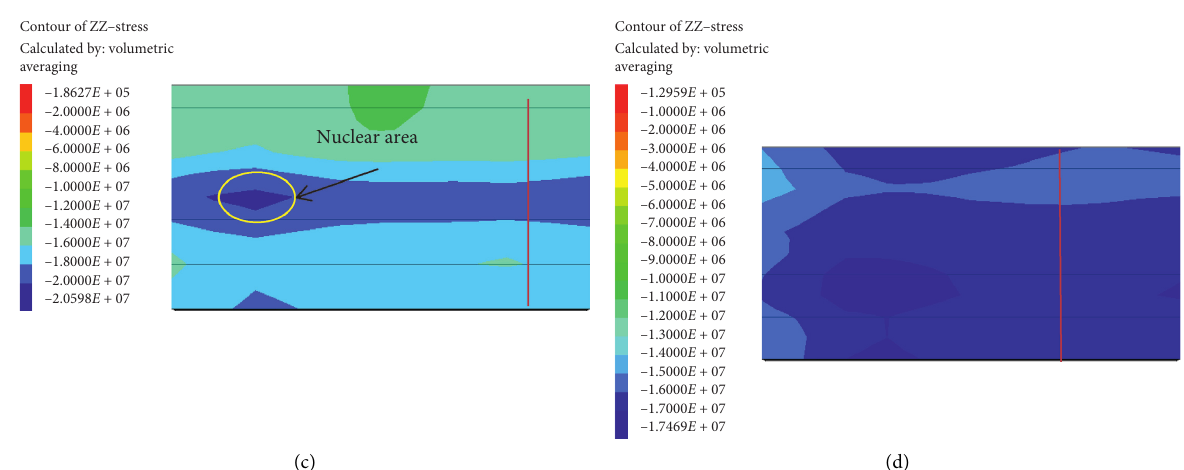
Figure 11: Advanced vertical stress cloud diagram of the third left working face. (a) The working face is advanced by 100m. (b) The working face is advanced by 200m. (c) The working face is advanced by 300m. (d) The working face is advanced by 400m.